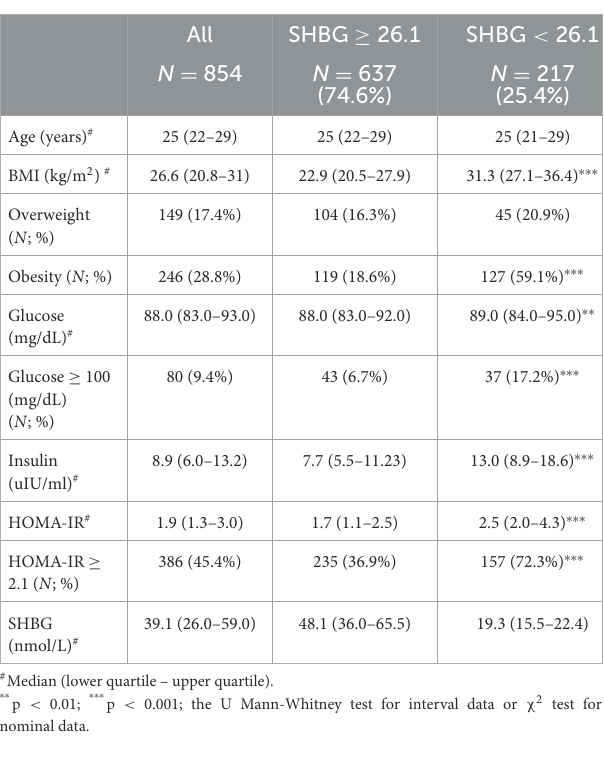
TABLE 1 Characteristics of the study group and subgroups.